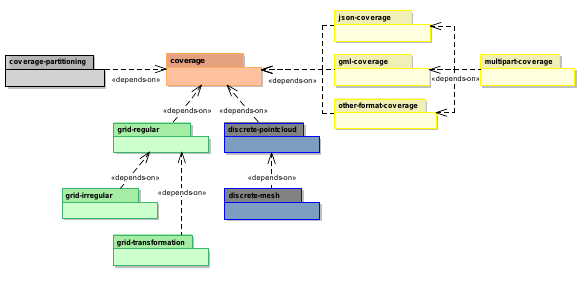
Figure 2. Coverage Implementation Schema (CIS) 1.1 conformance classes [8]